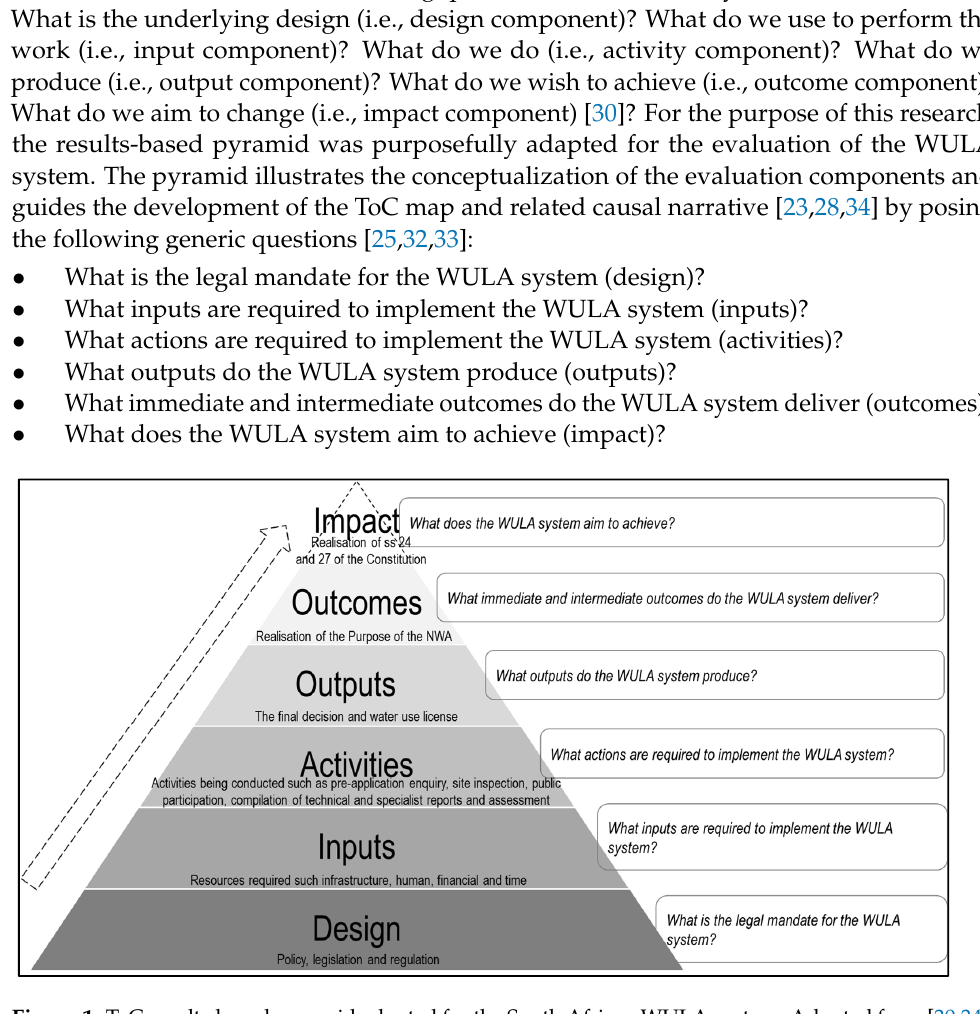
Figure 1. ToC results-based pyramid adapted for the South African WULA system. Adapted from